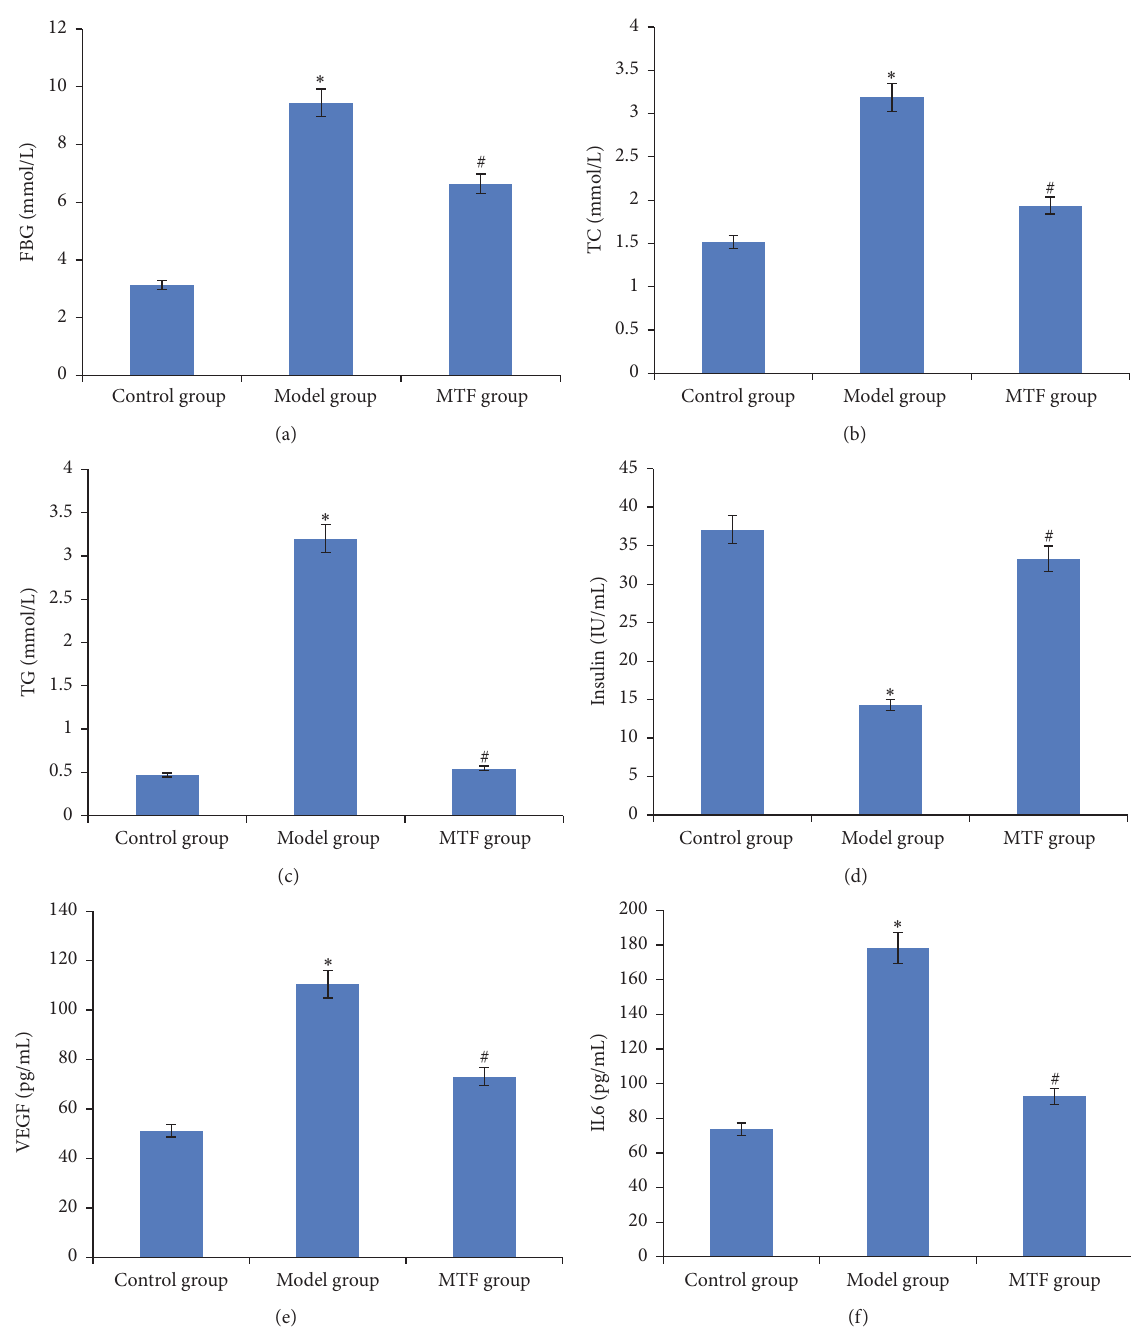
Figure 1: Blood indicators across three groups. (a) Level of FBG in blood; (b) level of TC in blood; (c) level of TG in blood; (d) level of insulin in blood; (e) level of VEGF in blood; (f) level of IL6 in blood. ∗ Significant difference between the control and model group ( 𝑃 < 0.01 ). # Significant difference between the model and MTF group ( 𝑃 < 0.01